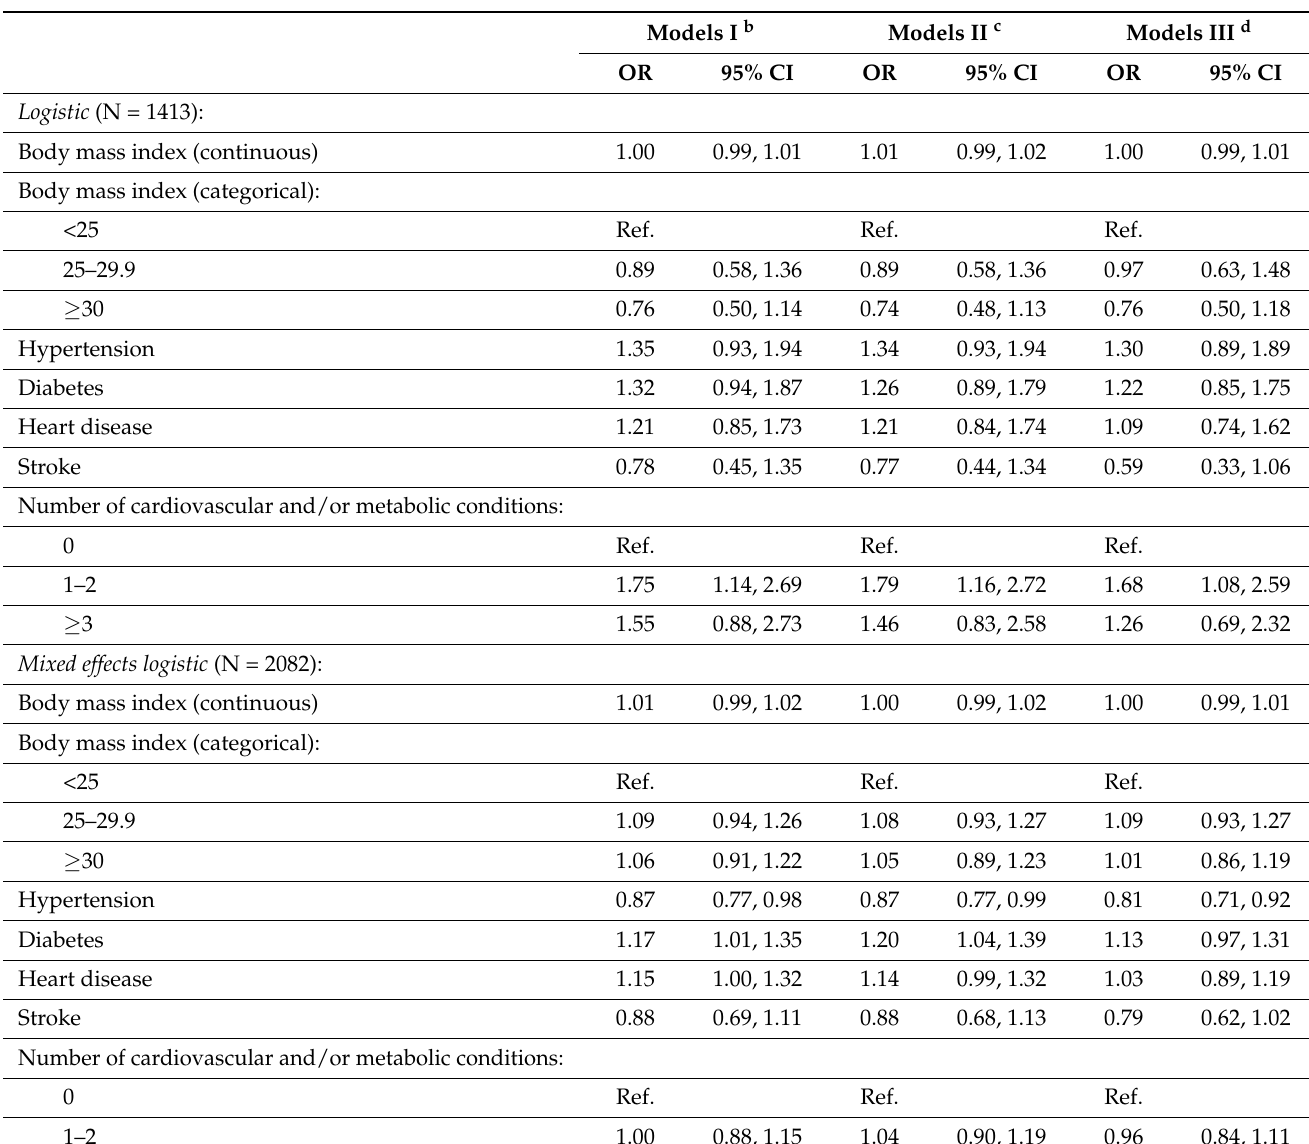
Table 4. Logistic regression models for cardiovascular and/or metabolic condition as predictors of non-surgical delays–HRS COVID-19 half-sample a